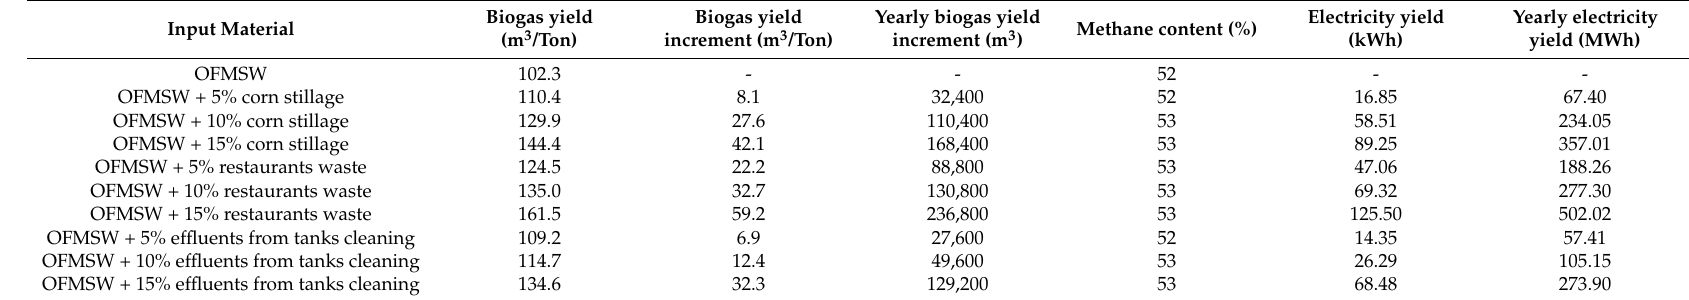
Table 1. Electricity production